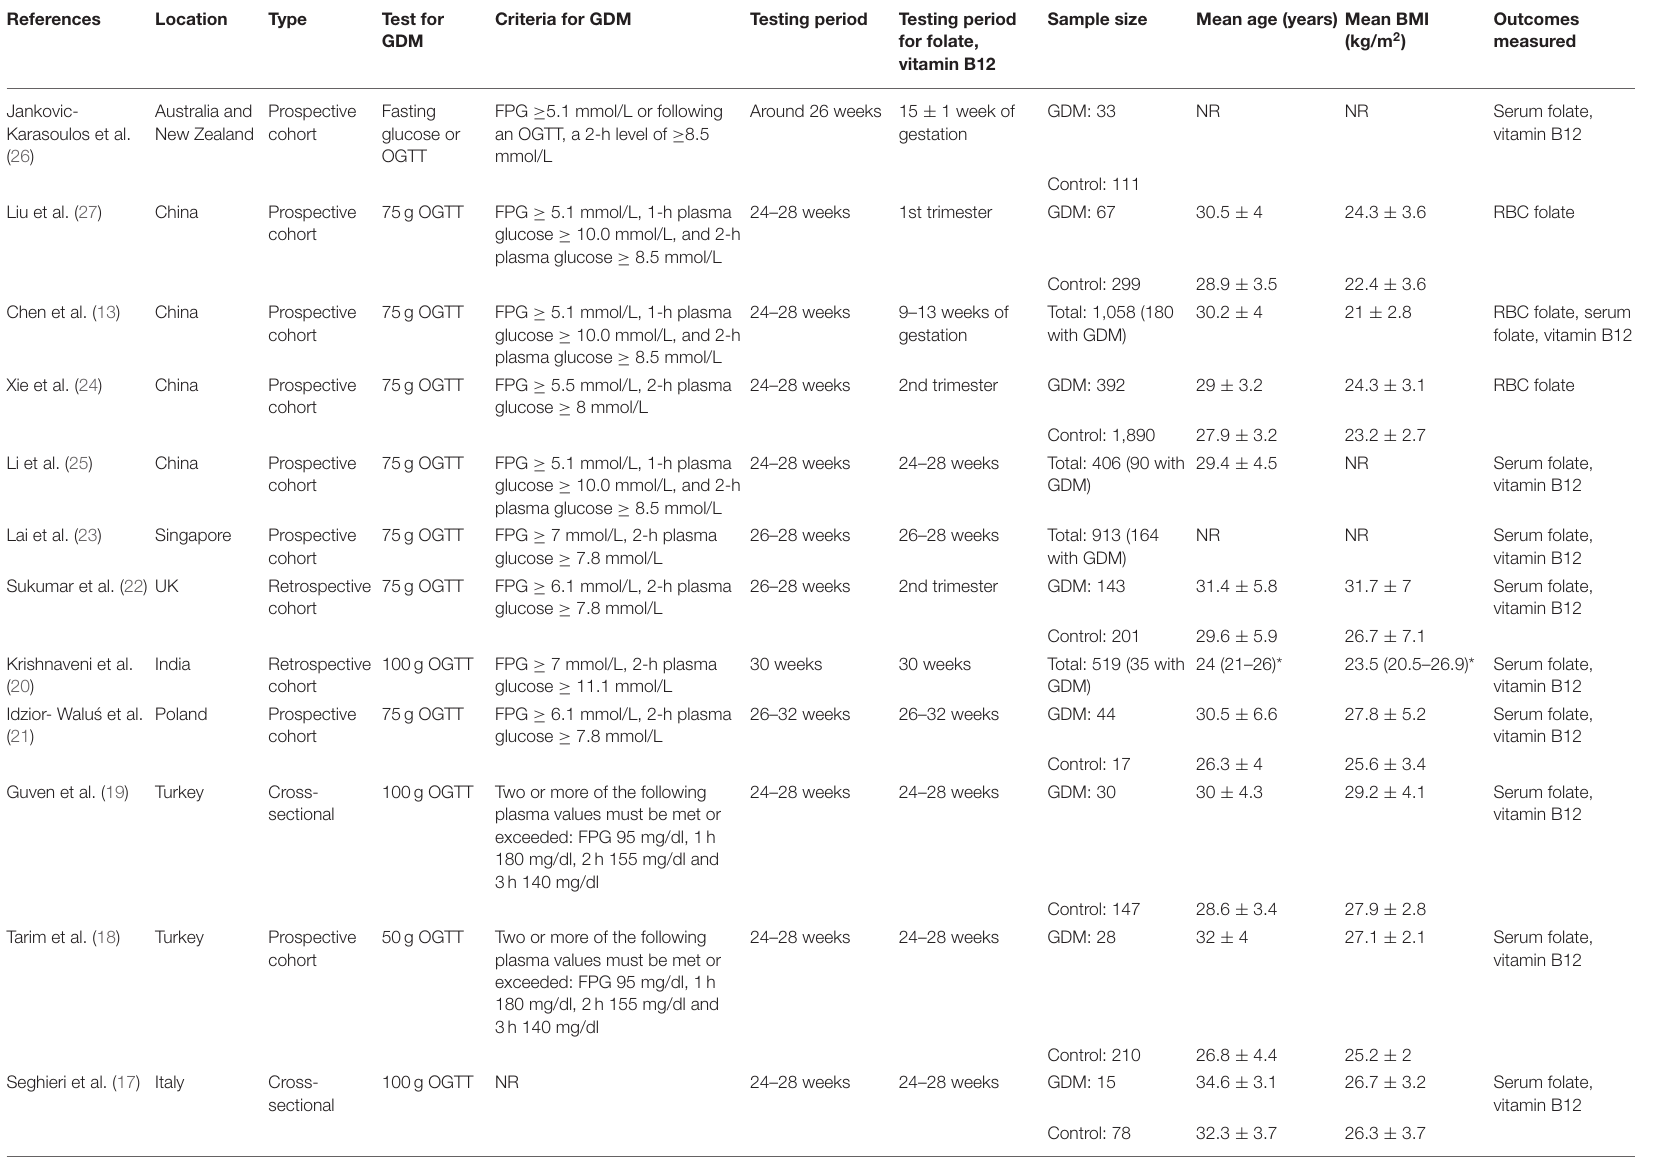
TABLE 1 | Characteristics of included